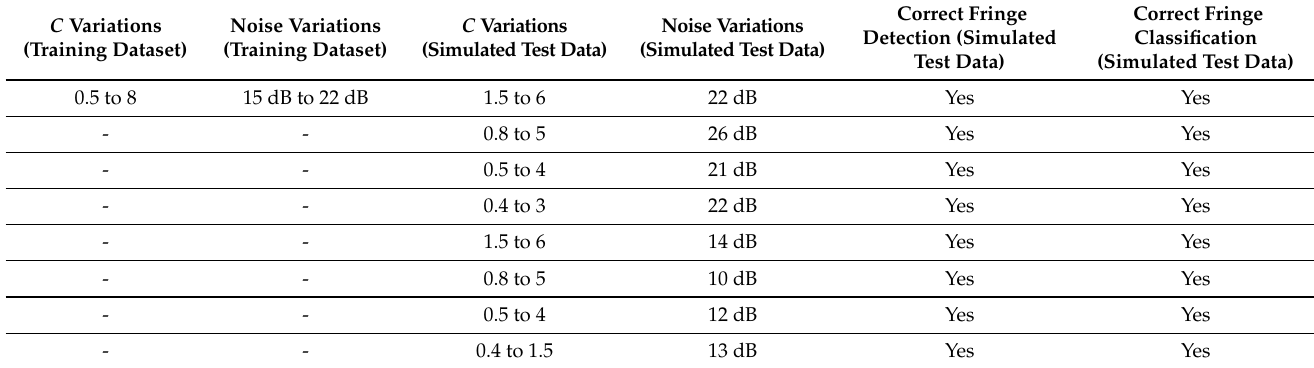
Table 1. Performance of both DNNs in terms of detection and classification as a function of C and SNR for simulated data.